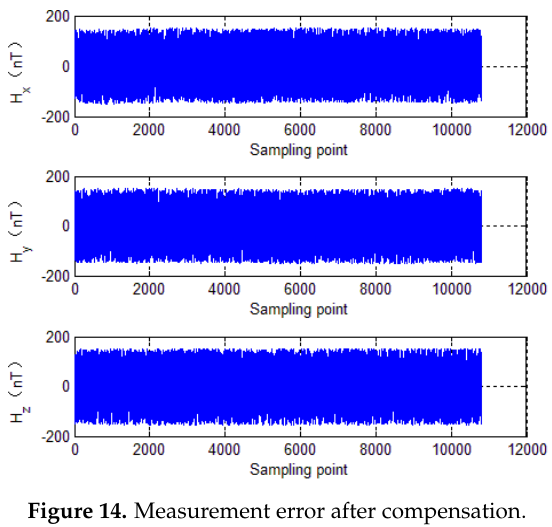
Sensors 2018 , 18 , x Figure 14. Measurement error after compensation. Figure 15. Total intensity of the magnetic field. Figure 14. Measurement error after compensation.